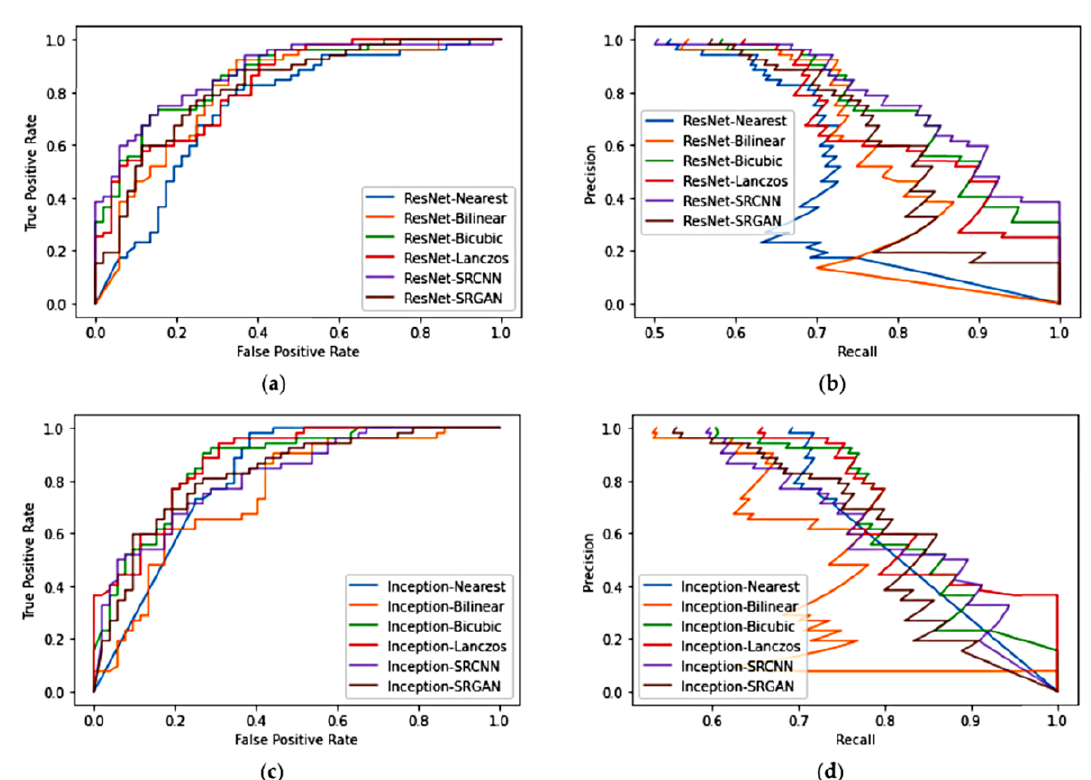
Figure 6. Curves obtained for the considered models. ResNetNearest, ResNetBilinear, ResNetBicubic, ResNetLanczos, ResNetSRCNN, and ResNetSRGAN: ( a ) ROC curves and ( b ) PR curves. InceptionNearest, InceptionBilinear, InceptionBicu- bic, InceptionLanczos, InceptionSRCNN, and InceptionSRGAN: ( c ) ROC curves and ( d ) PR